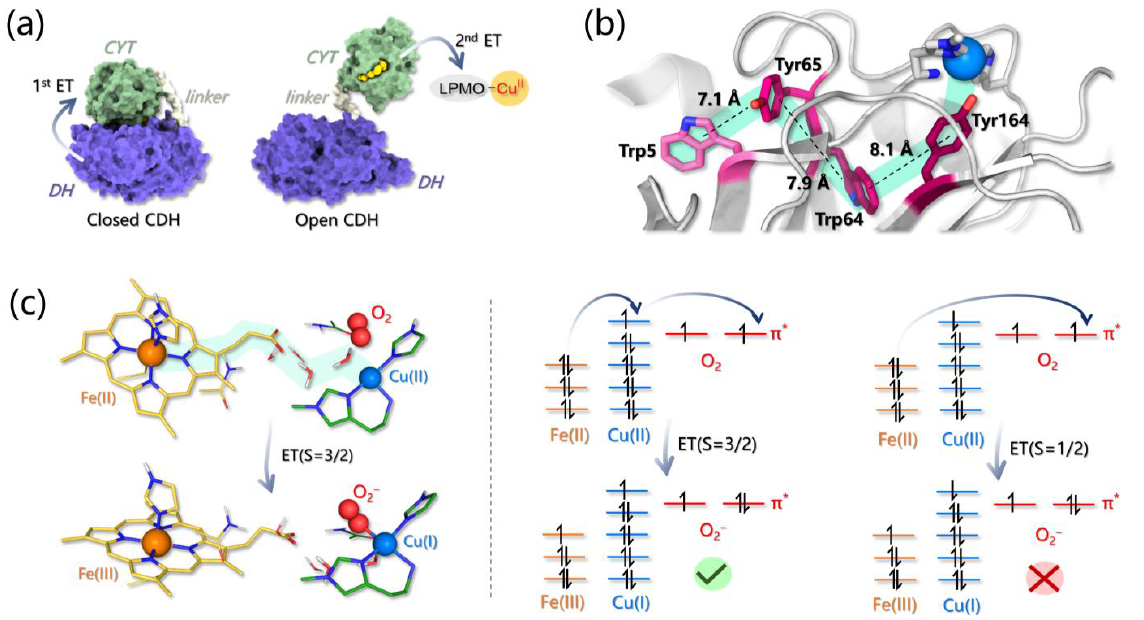
Figure 5. ( a ) Mechanism of the two ET from CDH to LPMO. First, the electron is transferred from DH to CYT and then from CYT to Cu(II). The structures of the closed and open conformation of CDH correspond to the PDB 4QI6 and 4QI7, respectively. ( b ) Proposed ET pathway in LsAA9 (PDB: 5ACG). ( c ) Optimized QM-portions (taken from ref [107]) of the CYT-LPMO system in the presence of oxygen before and after the ET (left) and molecular orbital occupations for the ET process in 3/2 and 1/2 state. In the 1/2 state, the electron must go directly to the O 2 molecule and the final Fe(III)Cu(I) system is found in an open-shell singlet state, which is quite unstable if compared to the triplet one.